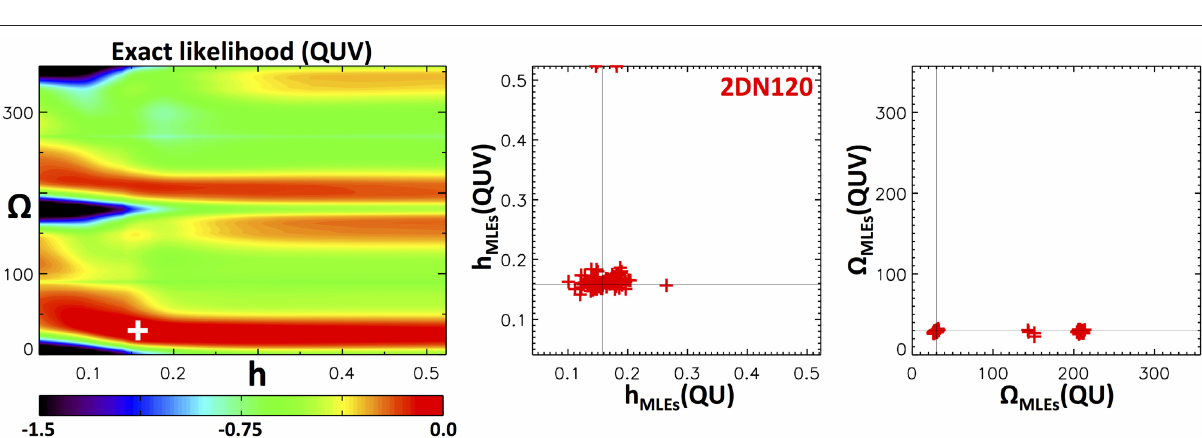
FIGURE 8 | Likelihood function with multiple maxima. (A) Scatter plots of the maximum likelihood estimators (MLEs) found for each design of the 2DN120 (red crosses) case. (B) Surface plot of the exact log-likelihood function possessing 2 global ( (cid:127) = { 30 ; 210 } ◦ ) and 2 local ( (cid:127) = { 150 ; 330 } ◦ ) maxima. (C) Approximated log-likelihood function with the best MLE of 2DN120. The white and black crosses highlight the position of the exact maximum (i.e., ground-truth). The purple solid lines show 0.95 × max ( ℓ ) isocontours.